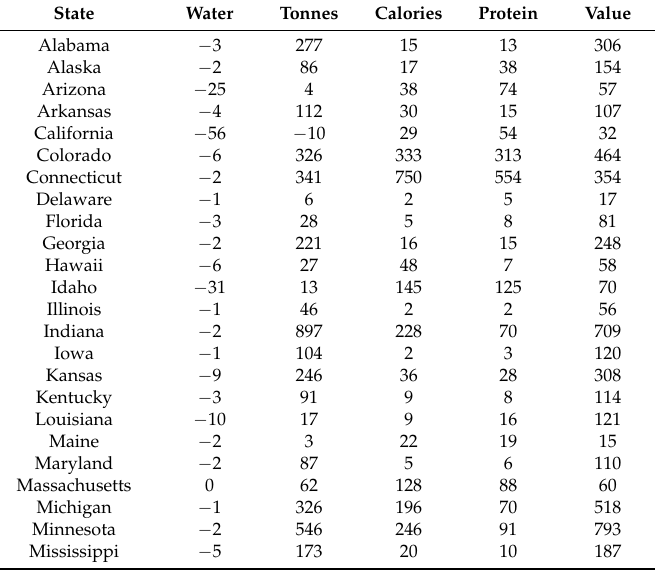
Table 3. Percent change in water demand, production, and economic value by